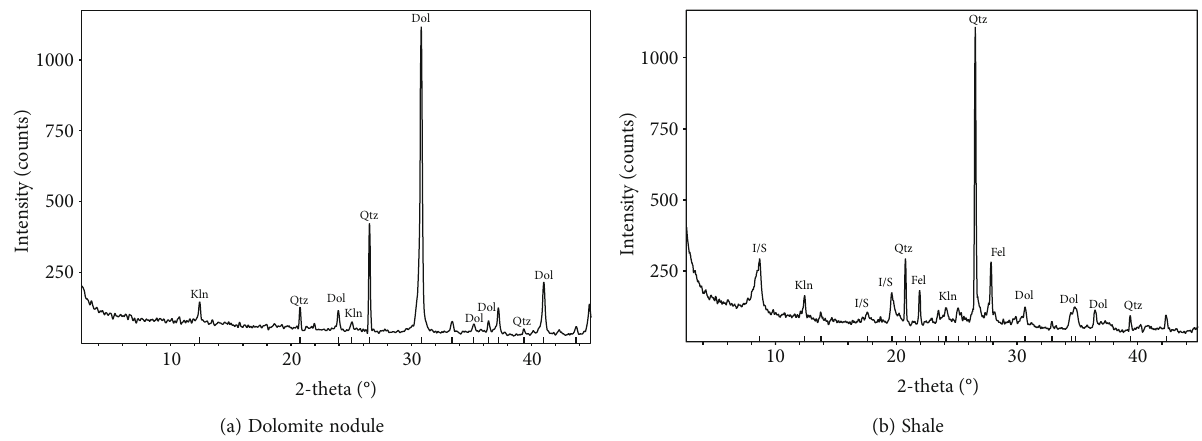
Figure 2: X-ray di ff raction (XRD) spectra of the dolomite nodule and host black shale. Kln: kaolinite; Qtz: quartz; Dol: dolomite; I/S: illite/ smectite; Fel: